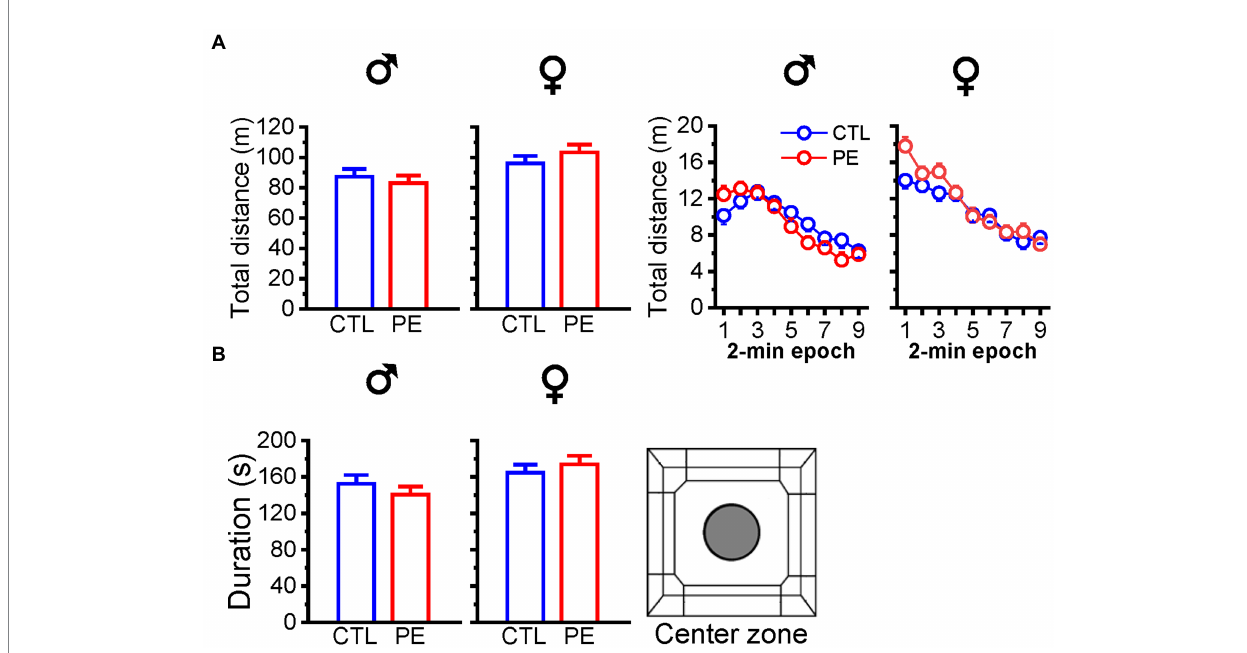
FIGURE 2 Effects of prenatal ethanol exposure (PE) on total distance in the OF and duration in the center zone in male and female rats under lower ambient light (14 lux). Prenatal ethanol exposure did not alter total distance travelled in the OF (A) or duration spent in the center zone (B)